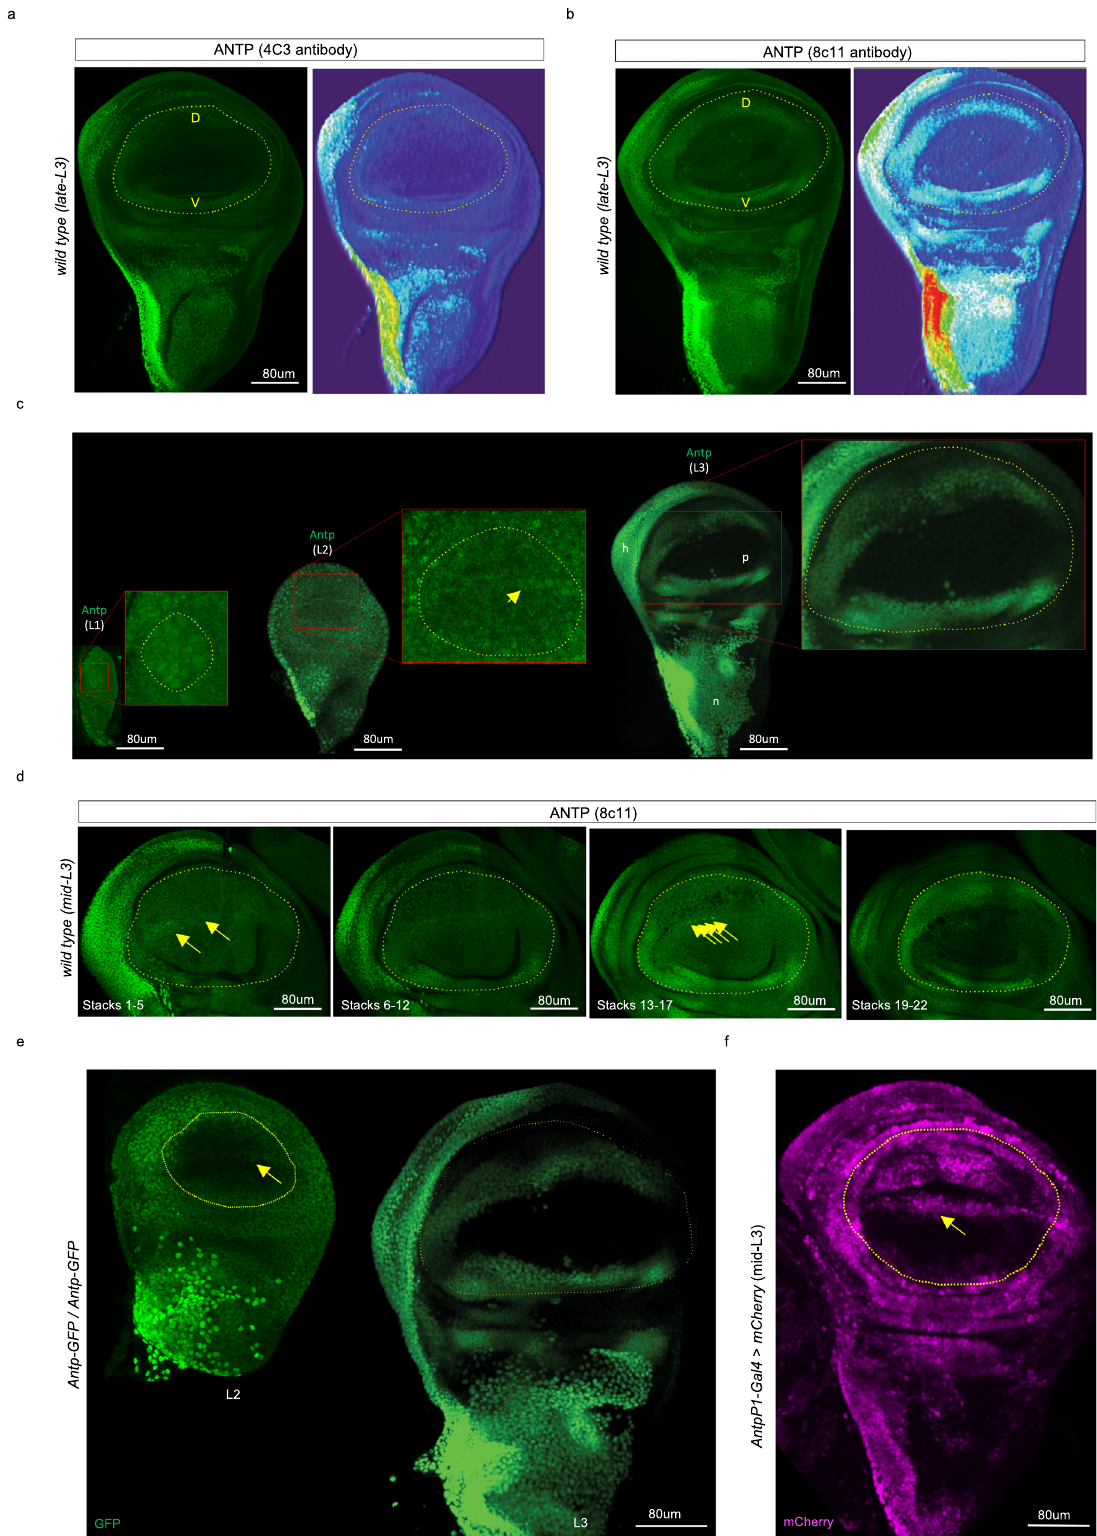
Ubx mutant background leading to the four-winged fl y exhibited the de novo wing-like expression pattern of Antp and a strong reduction of Ubx expression in the pouch of the T3 haltere-to- wing transformed disc (Fig. 5c, d). Together, these observations underlined that the particular expression of Antp in the wing disc pouch is speci fi cally linked to the wing developmental program.